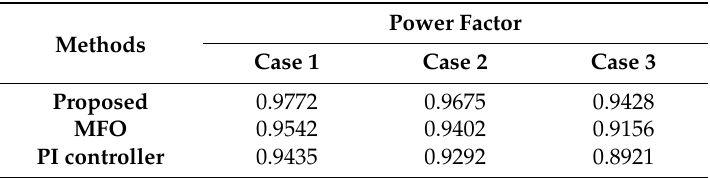
Table 1. Power factor of BLDC motor with proposed